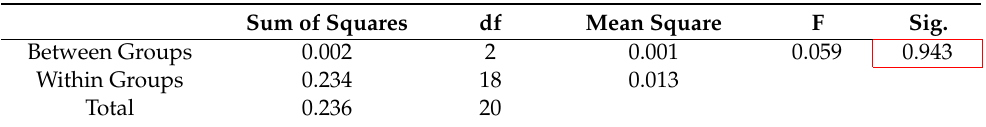
Table 6. Results of one-way ANOVA with the k value as 3, 5, and 7 (prediction success rate of grab gesture for each subject).